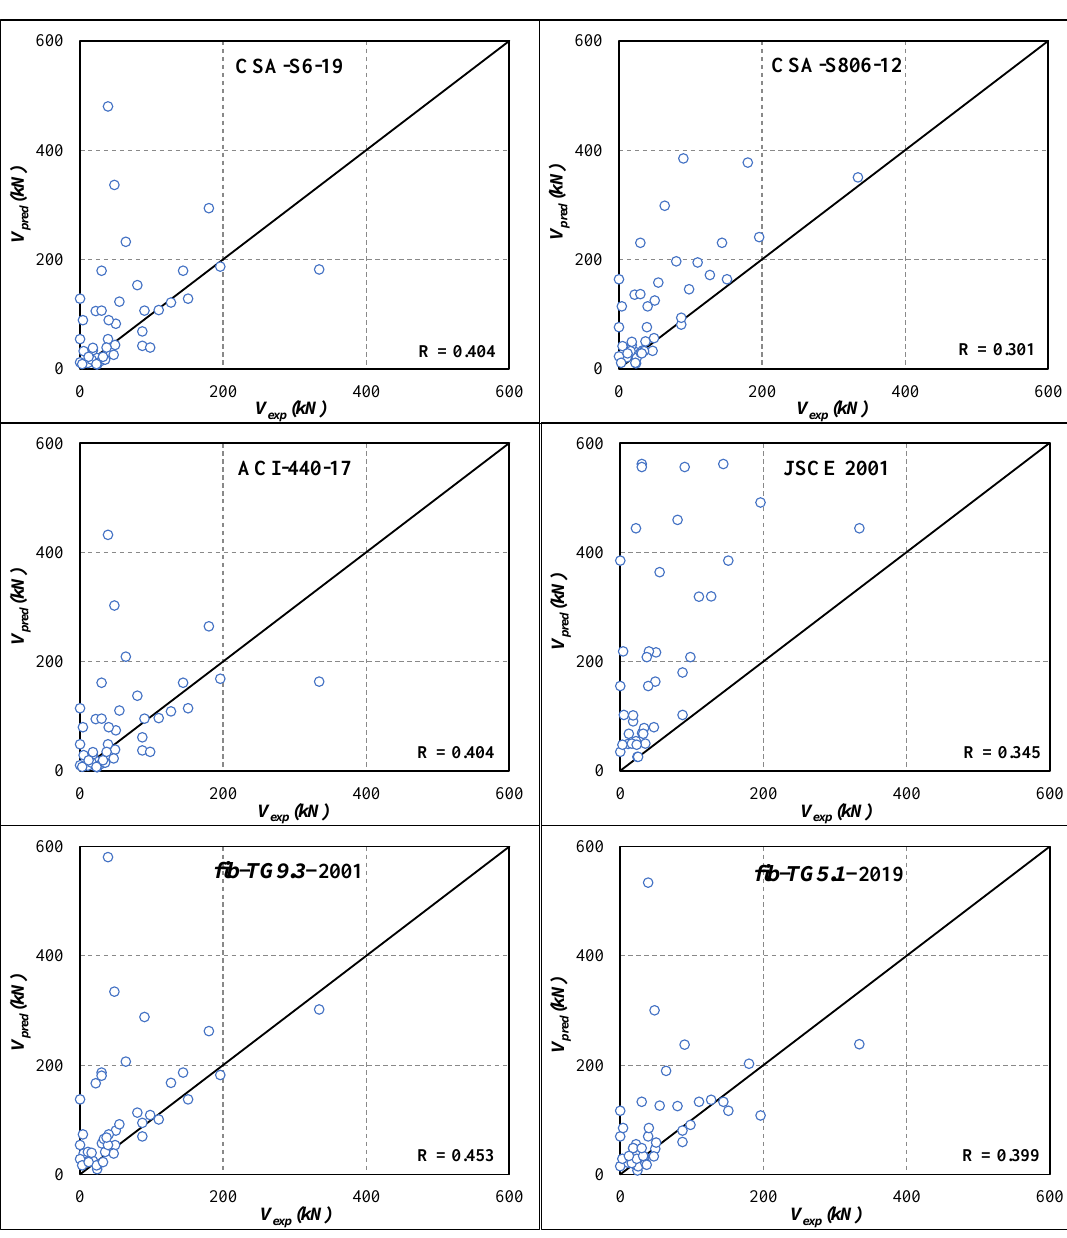
Figure 8. Comparison between predicted and experimental values.